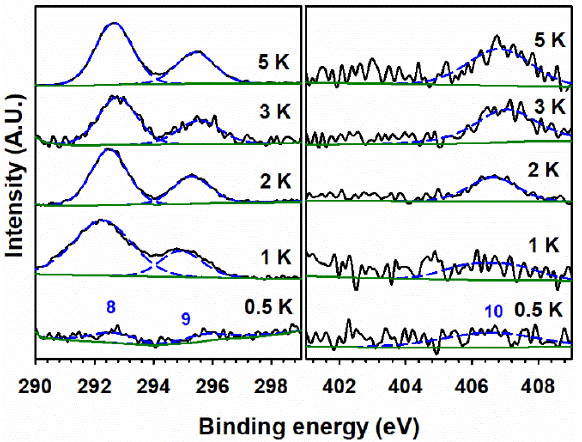
Figure 7. (Black trace) High-resolution XPS spectra of ( left panel ) K 2 p and ( right panel ) N 1 s for 100 Fe: x K materials, calcined at 400 °C, with the atomic ratio of potassium ( x ) indicated in each panel. (Dashed blue) Fitted peaks numbered (8) K 2 p 3/2 , (9) K 2 p 1/2 , and (10) nitrate. (Solid green) Fitted background.